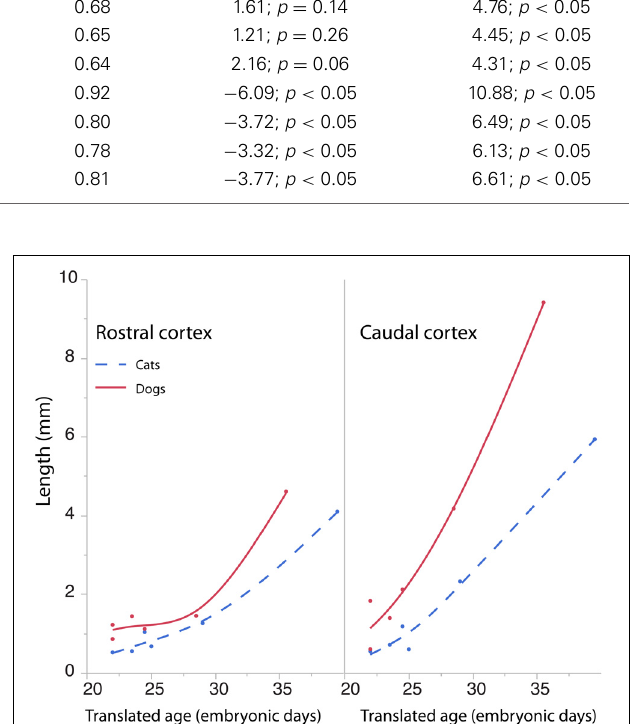
FIGURE 8 | Progenitor cells in the rostral and caudal regions of the cortex are regressed against translated age in dogs and cats. Estimated progenitor cells per mm 2 were multiplied by the length of the ventricular surface in the rostral or caudal region of the cortex. In the rostral cortex, the progenitor cells are roughly similar in both species but increase in the dog compared with the cat at the latest ages examined. In the caudal cortex, the progenitor cells are slightly higher in dogs than in cats at the earliest stages examined and become roughly three times more numerous in the dog compared with the cat at the latest ages examined.